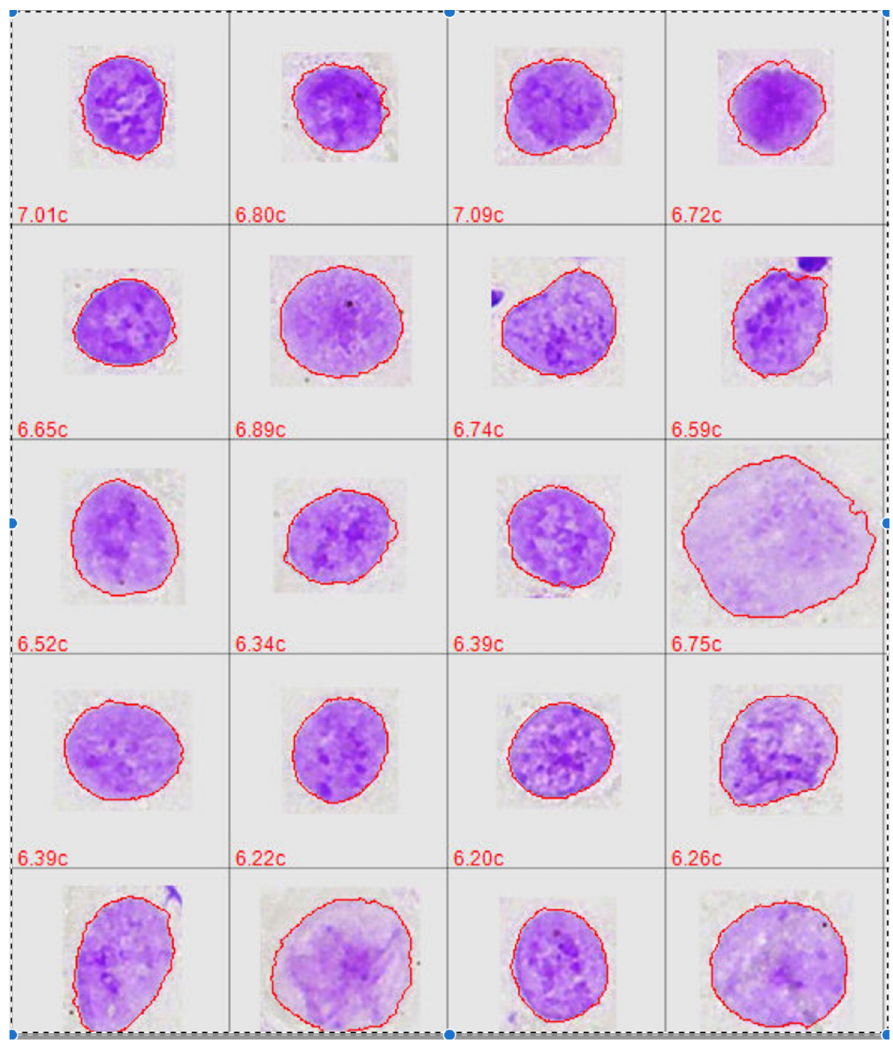
Figure 1. Nuclear images of automatically classified 20 Feulgen/pararosaniline-stained oral squa- mous carcinoma cells. Chromatin patterns and nuclear shaped can well be recognized.